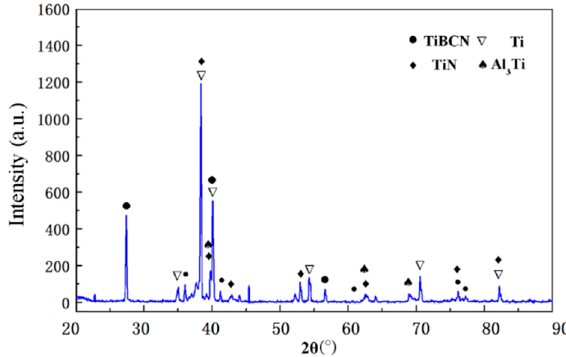
Figure 10. The XRD pattern of Ti / TiBCN coating.